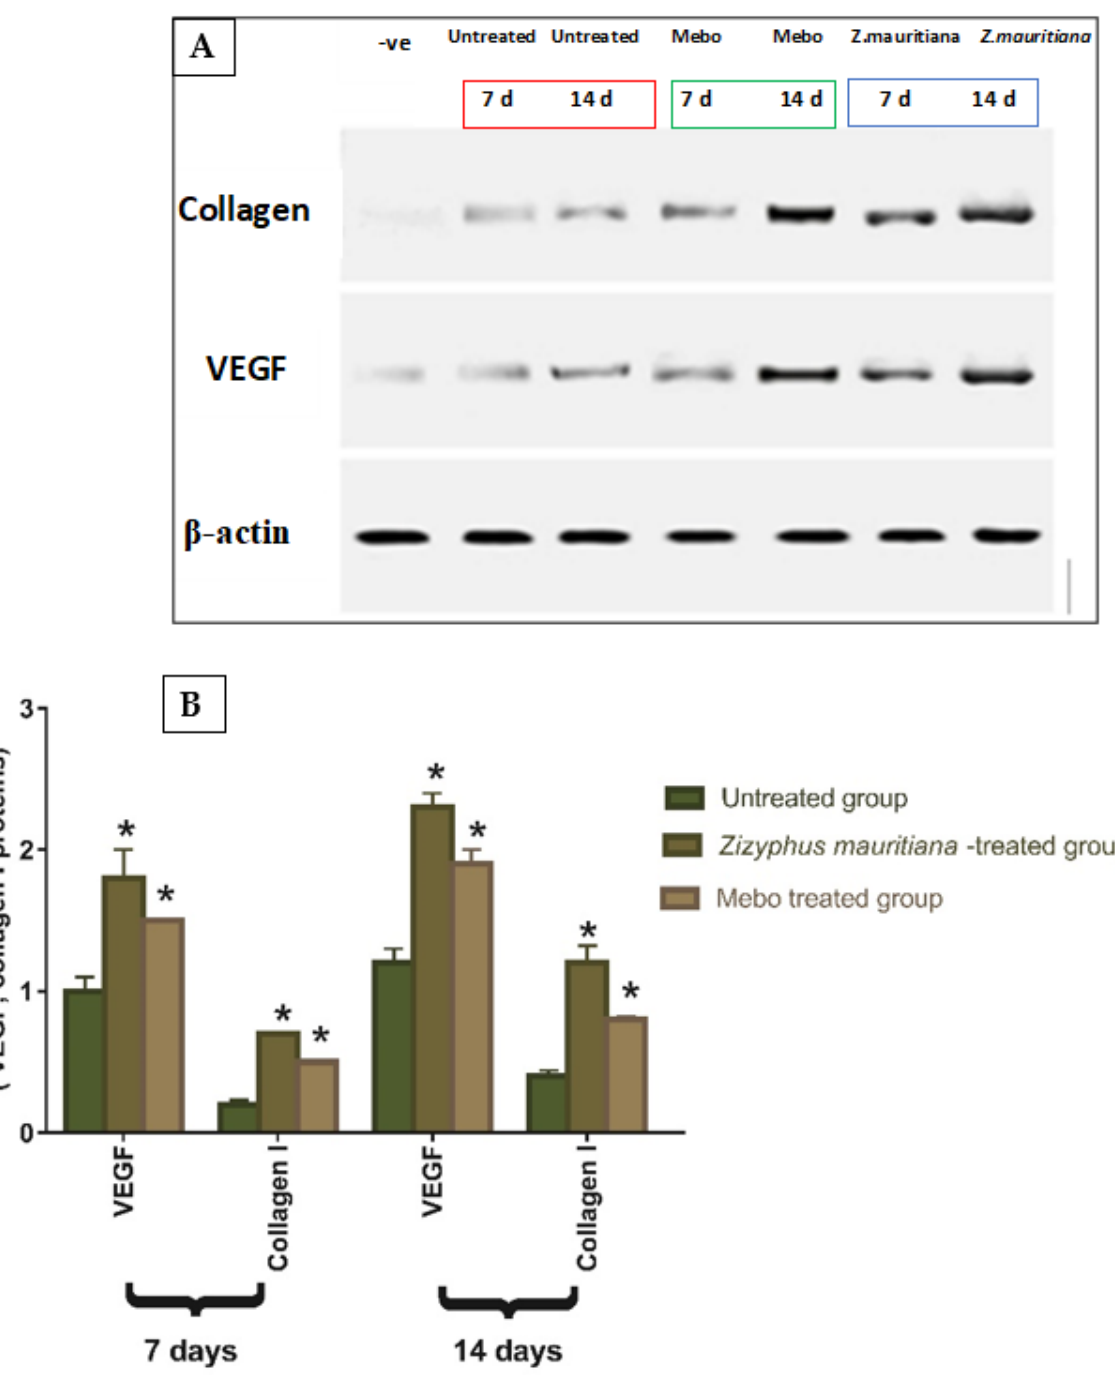
Figure 7. Effect of Z. mauritiana fruit extract on the expression of VEGF and collagen type I proteins: ( A ) Representative Immunoblotting of VEGF, collagen type I proteins, and β -actin proteins for all groups. ( B ) Expression of VEGF and collagen type I proteins, respectively, were expressed densitometrically (using bands) in after normalization to the corresponding internal control β -actin, as fold change relative to that of normal control rats. Bars represent mean ± SD. The significant difference between groups analyzed by a two-way ANOVA test, where: * p < 0.001 compared with those of the untreated group on the respective day.